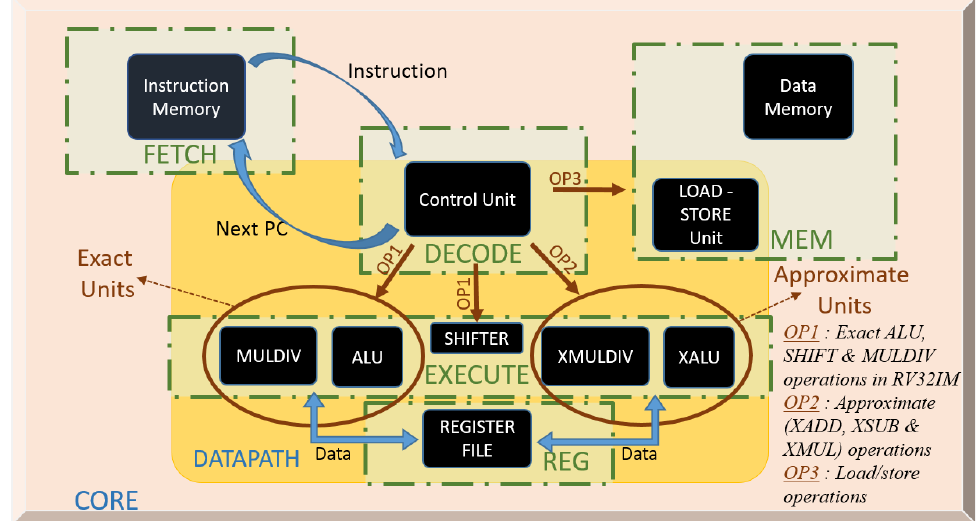
Figure 3. General flow diagram of the implementations in the proposed core.